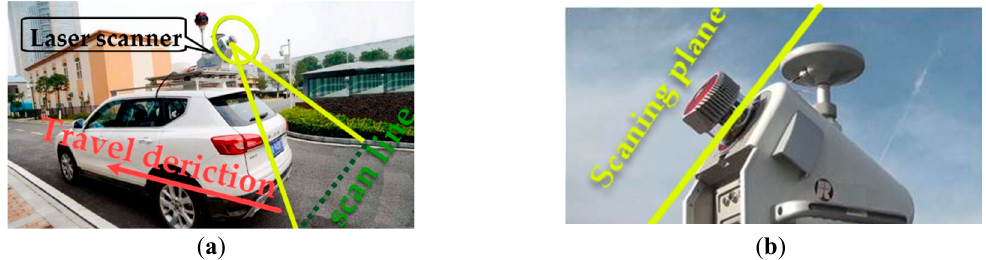
Figure 6. A single scanning line and its scanning plane. ( a ) A scanning line on the road; ( b ) side view of a scanning plane. of a scanning